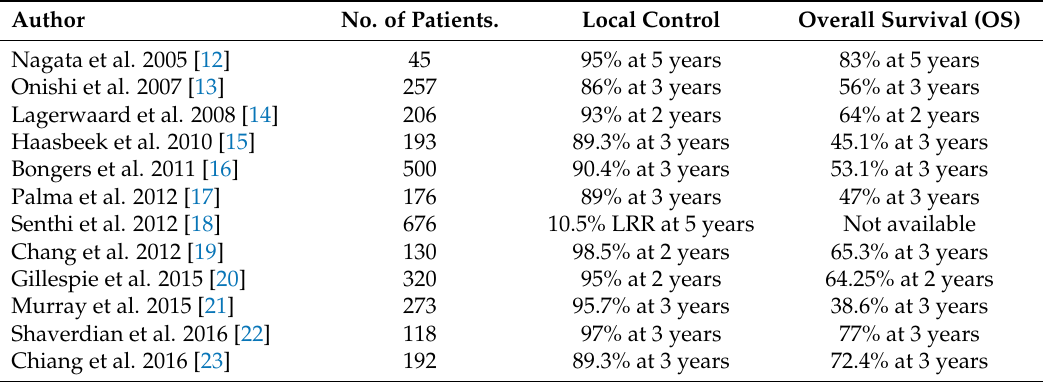
Table 1. Primary Non-Small-Cell Lung Cancer SBRT